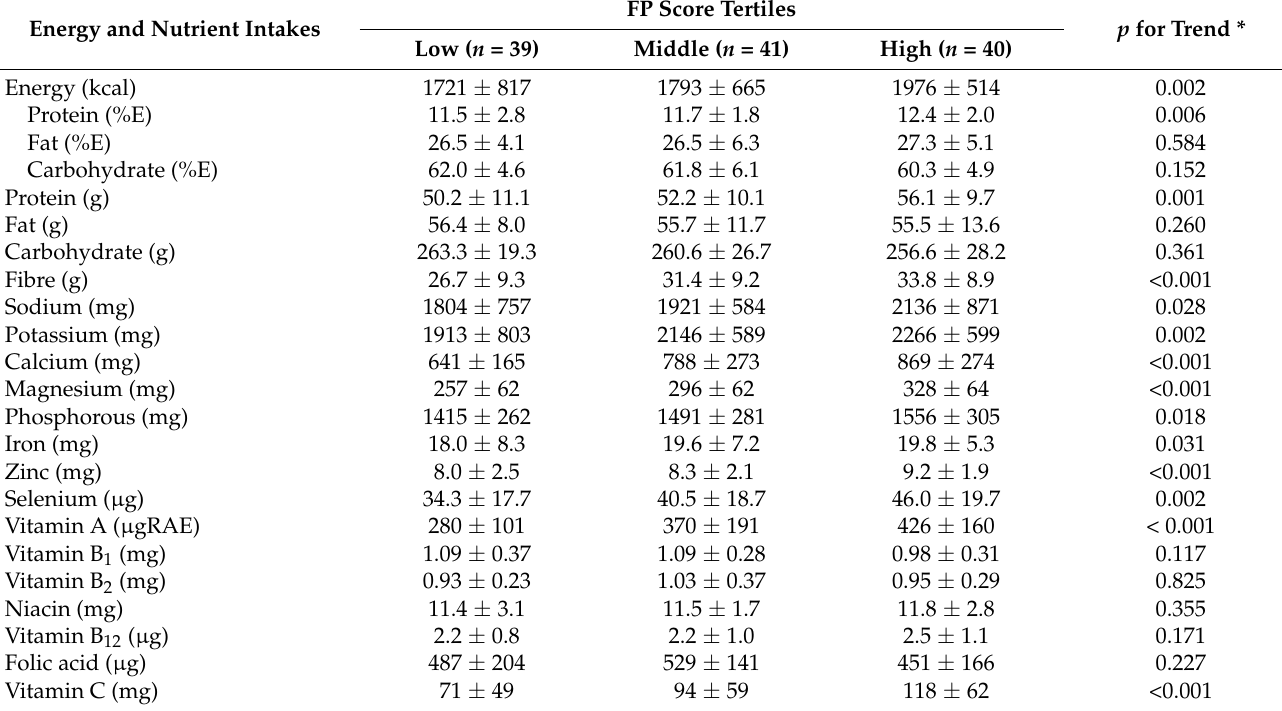
Table 3. Relationship between energy or nutrient intake and FP score